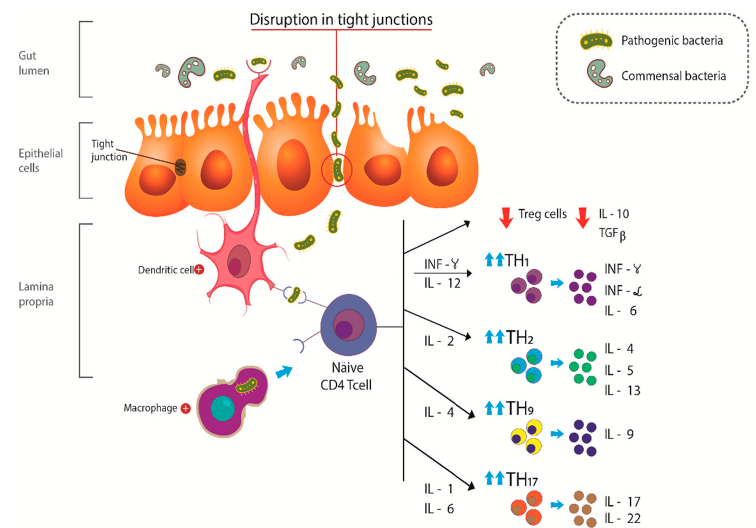
Figure 1. Pathophysiologic aspects of inflammatory bowel disease IBD. The disruption in tight junctions results in increased permeability of the epithelial cells leading to an augment in the uptake of antigens and activation of dendritic cells and macrophages, accompanied by decreased release of anti-inflammatory cytokines such as IL-10 and TGF- β , and increased release of proinflammatory cytokines such as INF- γ , TNF- α , IL-4, IL-5, IL-9, IL-17, and IL-22 (modified from Barbalho et al. 2018 [16]). IL: Interleukin; TGF- β : transforming growing factor- β ; INF- γ : interferon- γ ; TNF- α : tumor necrosis factor- α